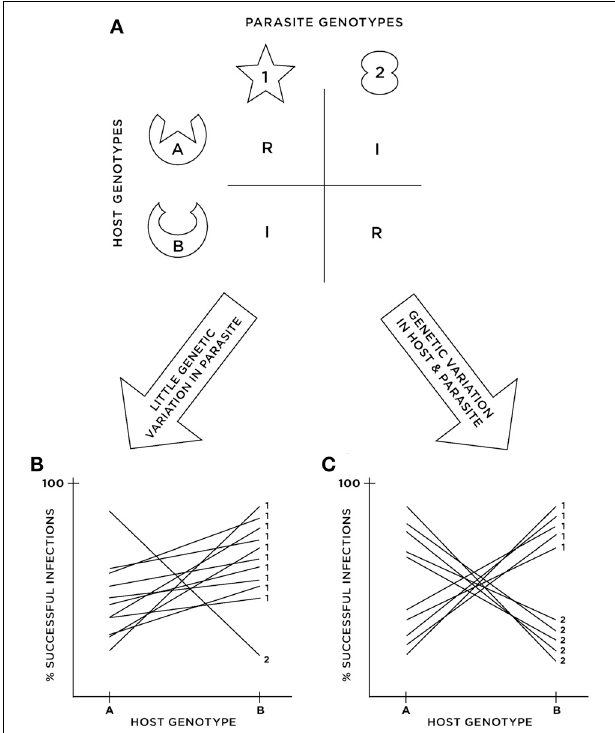
FIGURE 1 | Cartoon illustrating the potential disconnect between functional and statistical G × G. (A) Depicts an example of functional G × G where a “match” between host and parasite molecules triggers host defense, resulting in resistance (i.e., inverse matching alleles or IMA). (B,C) Depict the results of cross-infection studies in two different populations possessing the functional G × G in (A) . In (B) , parasite genotype 2 is rare in the population, resulting in a small G × G variance component, and thus an inferred lack of statistical G × G when analyzed with ANOVA. In (C) , parasite genotypes are in equal frequencies in the population, resulting in a large G × G variance component and thus strong evidence for statistical G ×